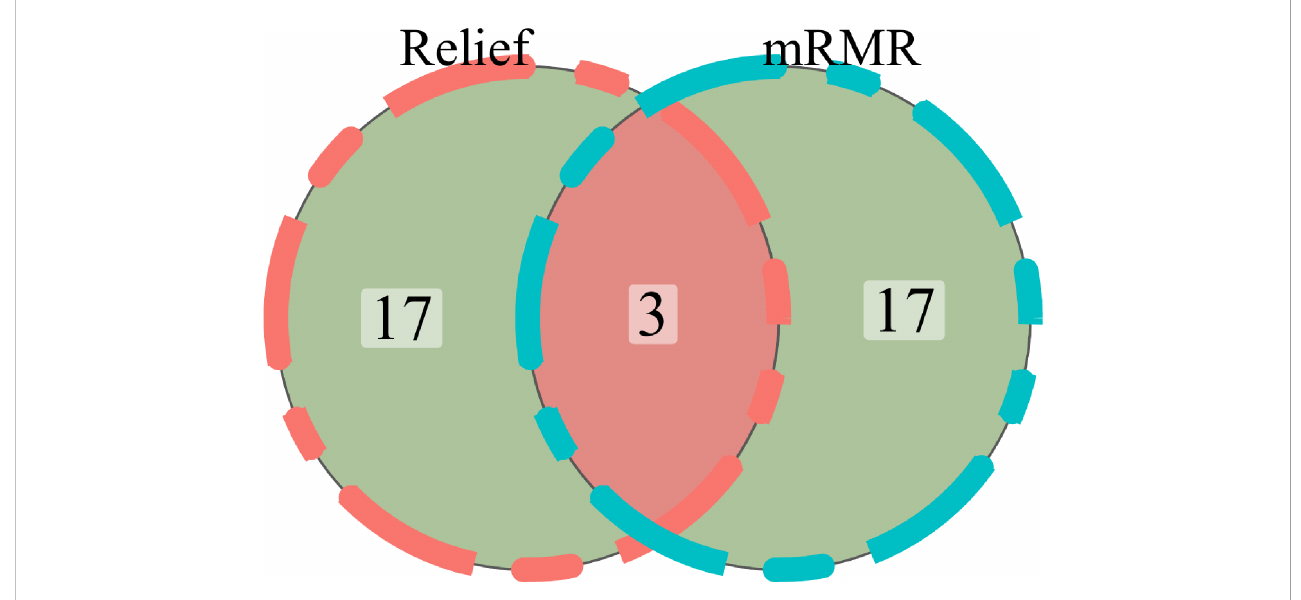
FIGURE 5 The Venn diagram showed the fi nal 3 radiomics